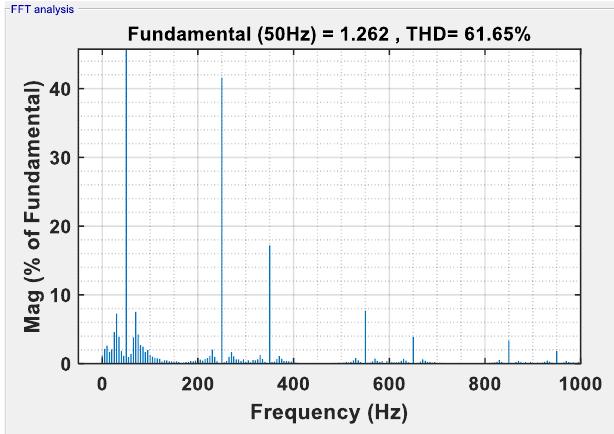
Figure 13. THD performance of the current without a filter.